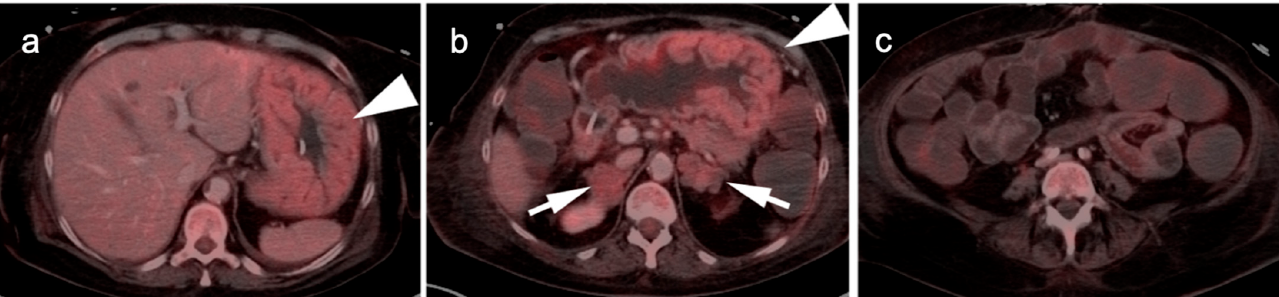
Figure 9. Two cases of gastric carcinoma on FDG PET-CT. ( a ) Axial fused FDG PET-CT image of the upper abdomen shows mild metabolic activity in the gastric cardia (with tumor involvement, white arrow). This degree of metabolic activity is similar to that in many normal patients; ( b ) Magnified axial fused FDG PET-CT image. A small nodular tumor on the posterior wall of the gastric antrum is only mildly metabolically active (white arrowhead) but is associated with two small hypermetabolic lymph nodes (white arrows) consistent with regional nodal spread.